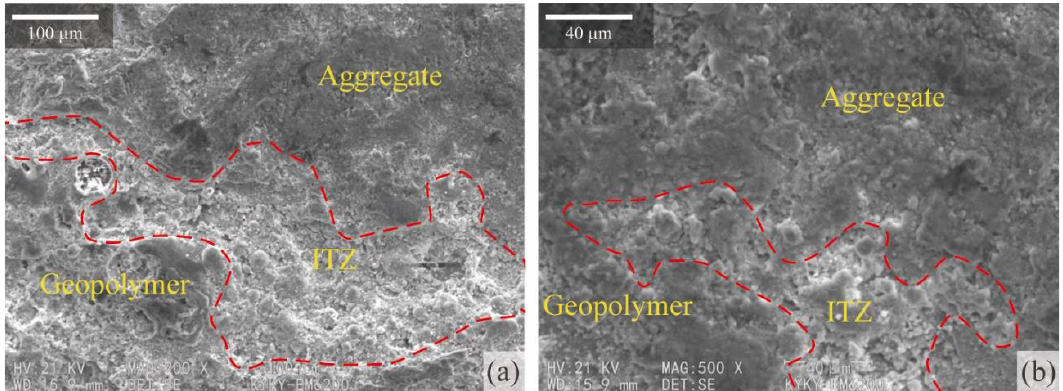
Figure 5. SEM images of slag/fly-ash-based geopolymer stabilized macadam ( a ) 100 μm. ( b ) 40 μm.